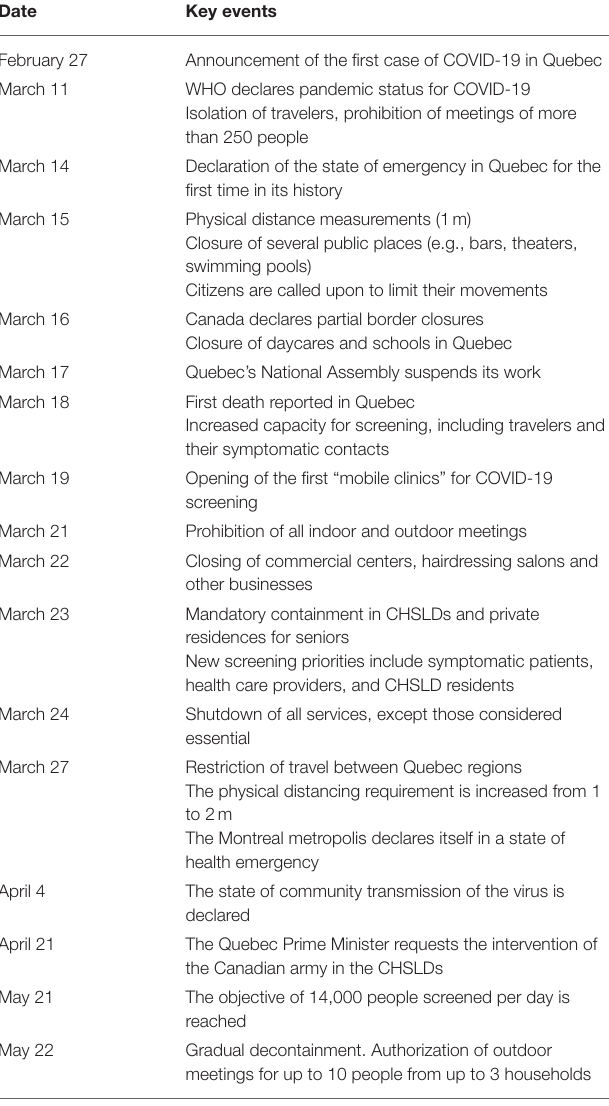
TABLE 2 | A brief chronology of key events related to the first wave of COVID-19 in Quebec